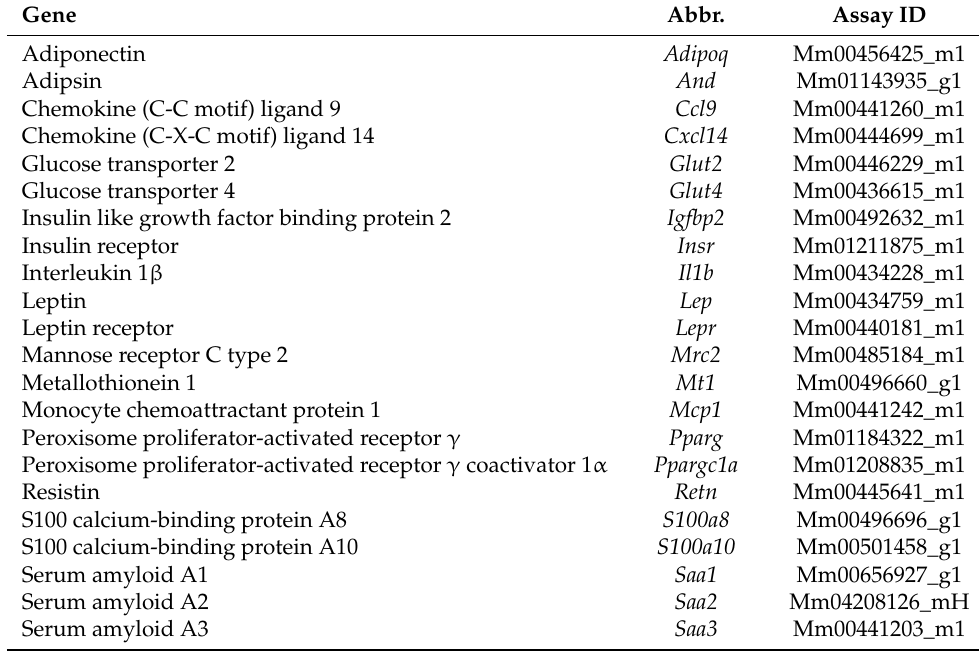
Table 5. TaqMan Gene Expression